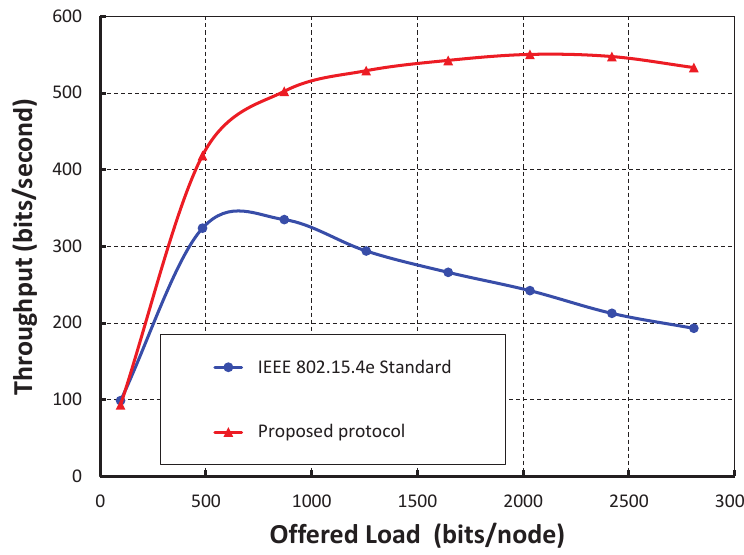
Figure 9. Comparison of throughput of our protocol with IEEE 802.15.4e.